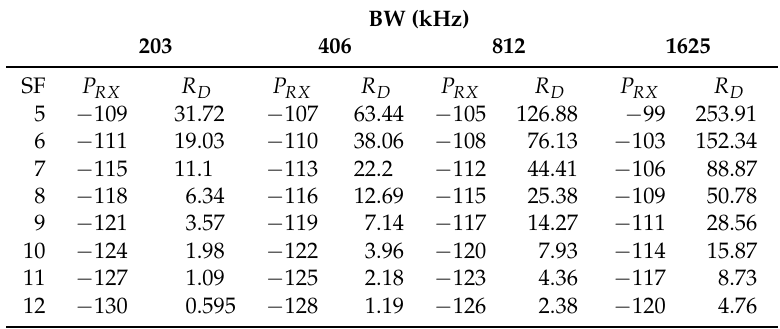
Table 2. Receiver sensitivities ( P RX in dBm) and corresponding data rates ( R D in kbit/s) of the SX1280 LoRa module for every combination of spreading factors (SFs) and bandwidths